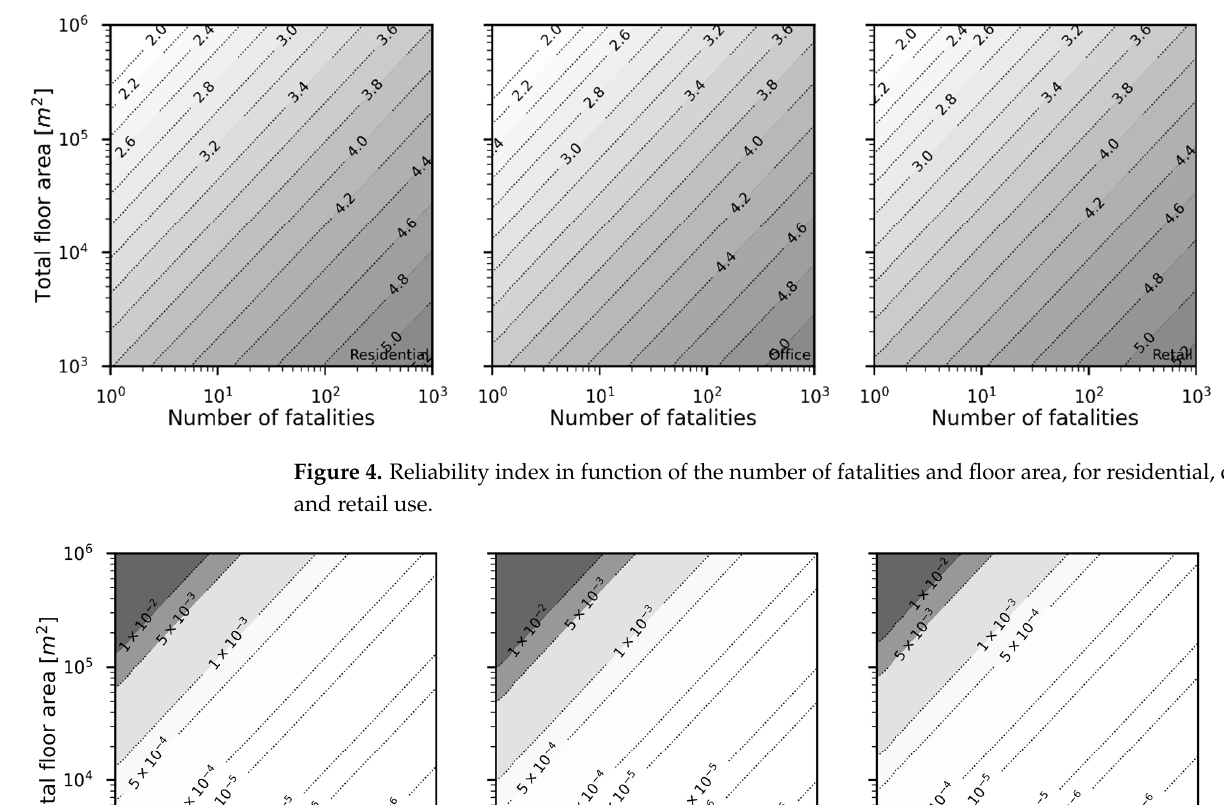
Table 11. Relevant cost parameters in the determination of acceptable reliability targets based on the principle of relative (marginal) lifesaving